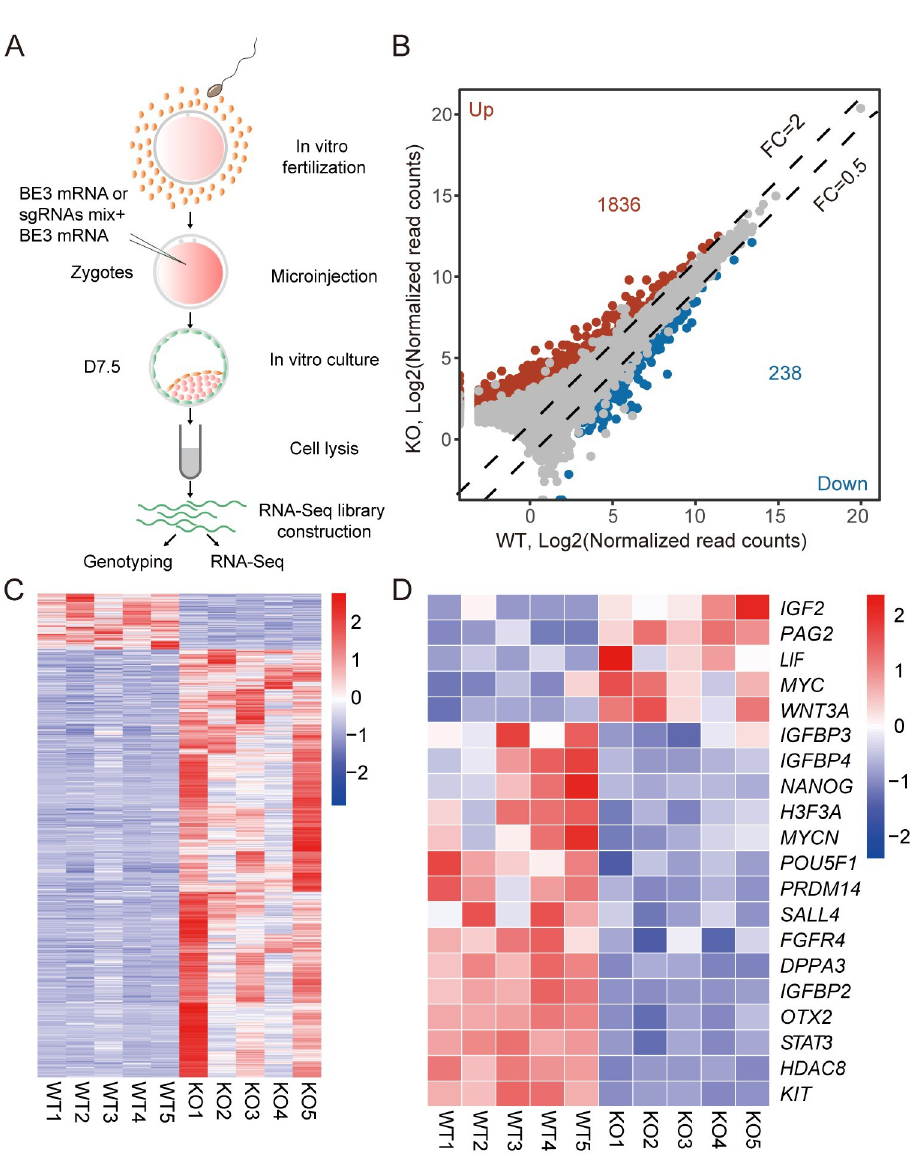
Fig 4. SOX2 knockout disrupts the network of pluripotency genes in bovine blastocysts. A. Experimental scheme of single D7.5 early blastocyst RNA-seq in WT and SOX2 KO groups. B. Volcano plot depicting differentially expressed genes, among which 1836 are upregulated and 238 are downregulated (Fold Change > = 2 or < = 0.5; Padj < = 0.05). C. Heat map showing all differentially expressed genes between WT and SOX2 KO groups. D. Heat map showing differential expression of genes involved in the regulation of pluripotency between WT and SOX2 KO